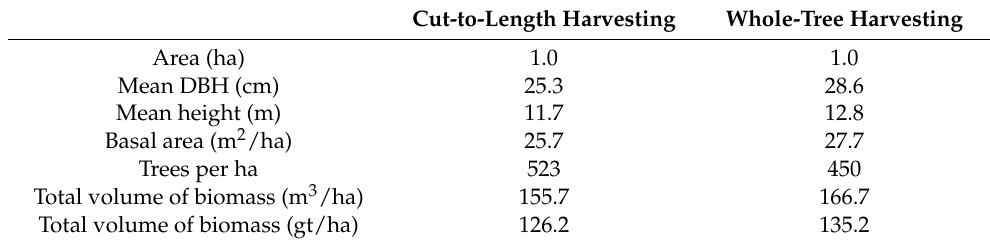
Table 2. Characteristics of the harvest